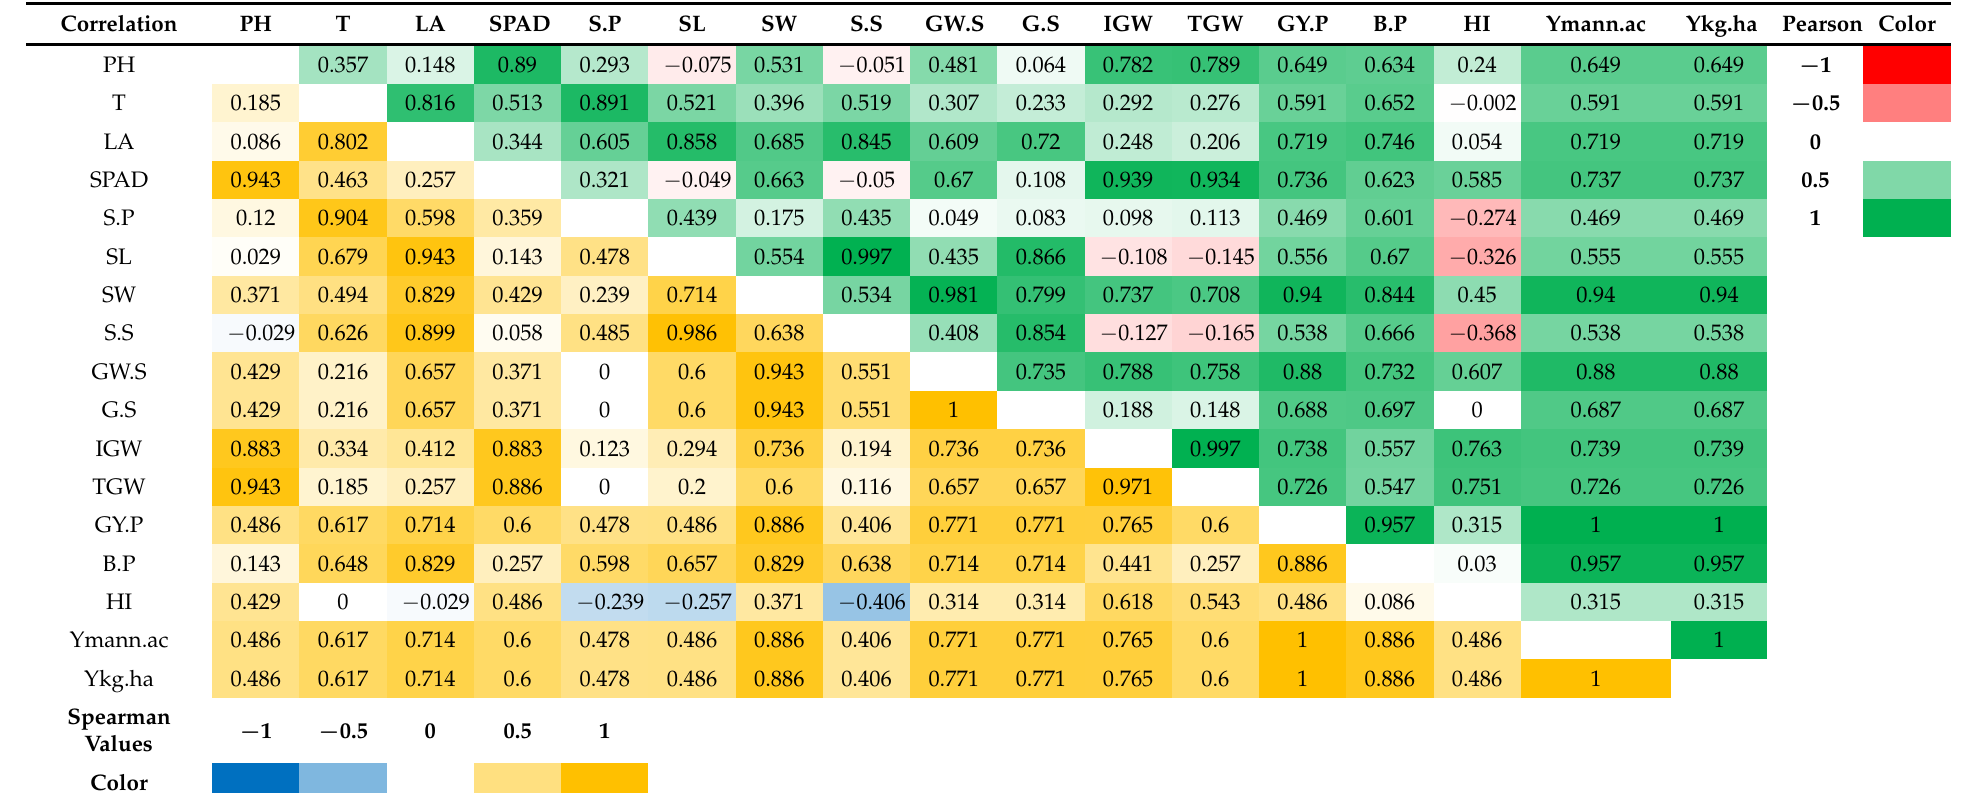
Table 2. Correlation between morphological attributes of the wheat plants grown under abiotic